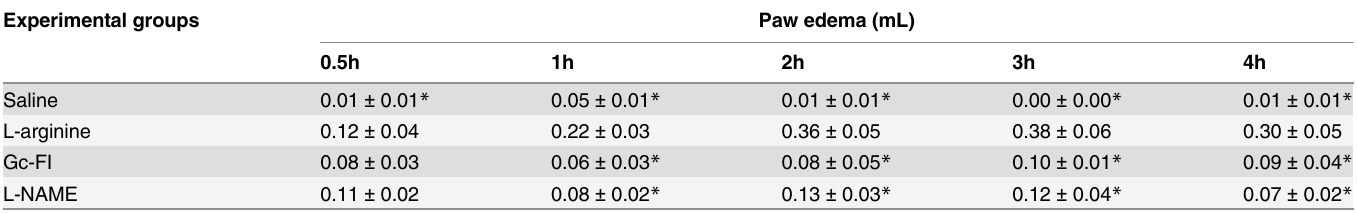
Table 2. Effect of Gc-FI on L-arginine-induced paw edema in rats. Experimental groups